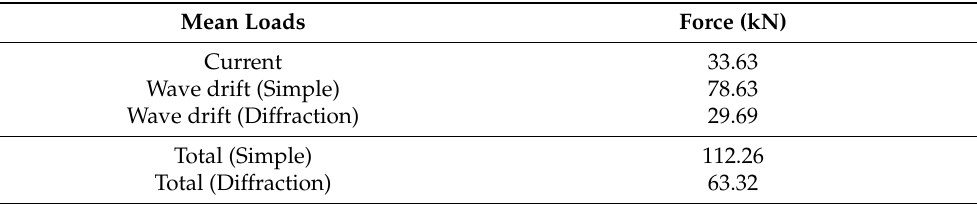
Table 2. Estimation of the mean environmental Loads.